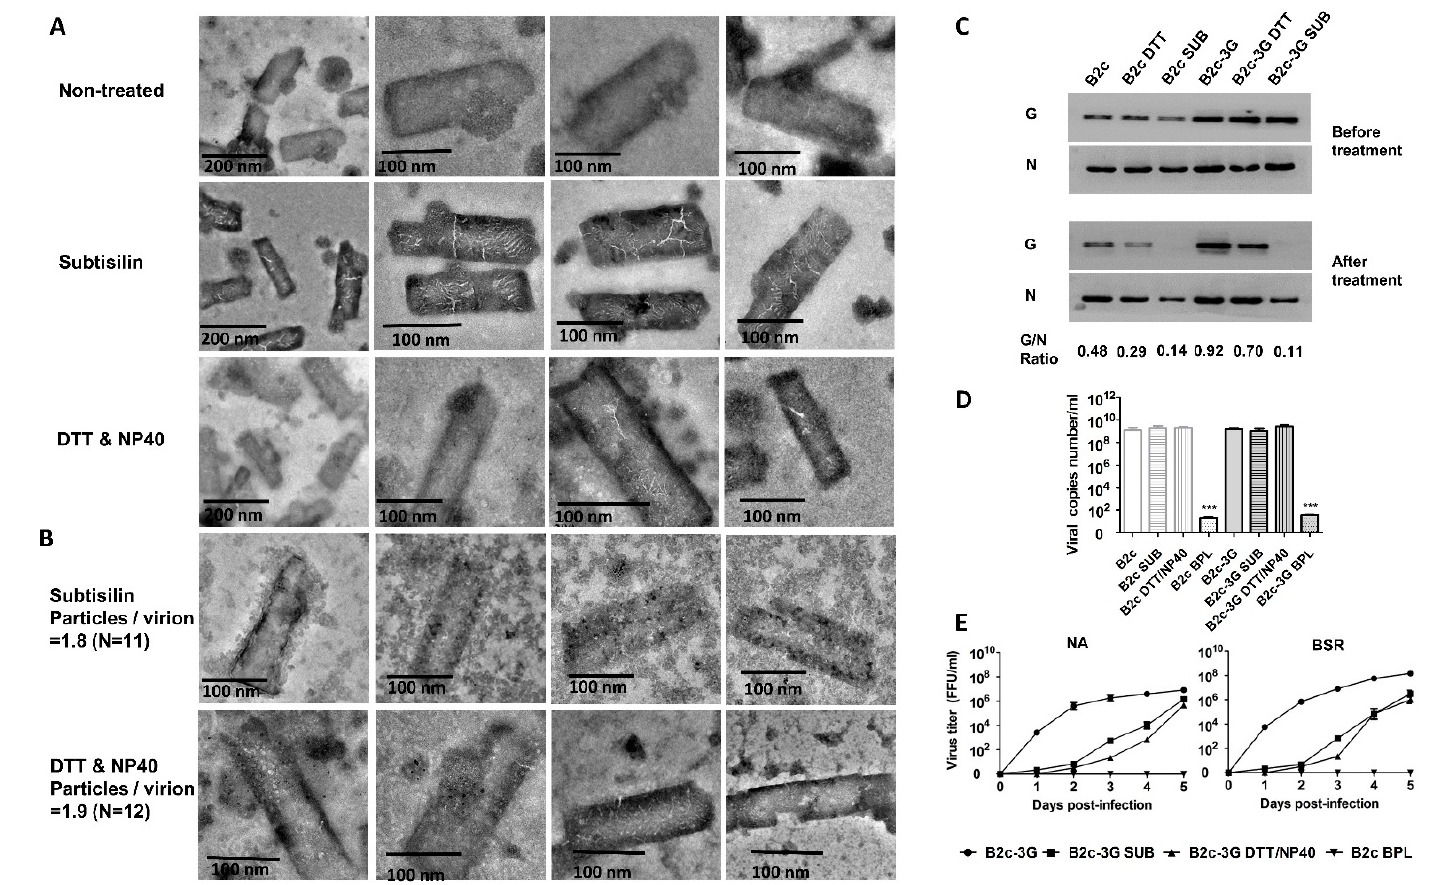
Figure 3. Removal of G from RABV virions after treatment with DTT/NP40 or subtilisin. ( A ) Morphological analysis of DTT/NP40- or subtilisin-treated RABV by electron microscopy after negative staining. ( B ) RABV-G protein on virions was detected by staining with RABV-G-specific antibodies labeled with 5-nm immunogold particles. ( C ) Western blot analysis of viral N and G proteins incorporated into virions. ( D ) Viral genomic RNA from RABV treated with or without DTT/NP40 or subtilisin and analyzed by qRT-PCR. ( E ) Growth curves of B2c-3G and B2c in the NA and BSR cells.